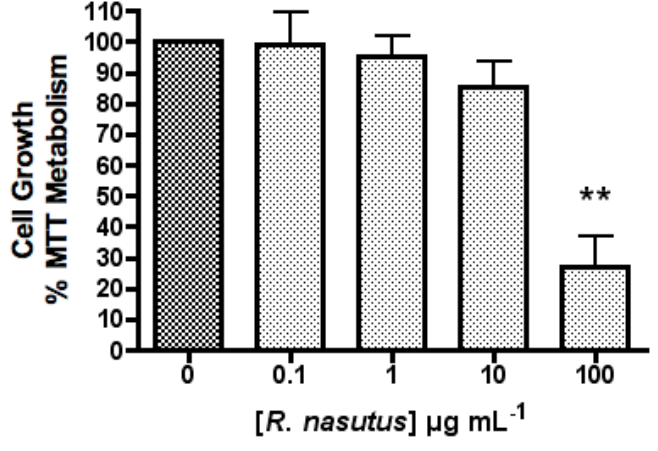
Figure 1. The effect of R. nasutus in HT-22 cells measured using the MTT assay. ** ANOVA Dunnett’s multiple comparison Post hoc test compared to control P < 0.01. n =